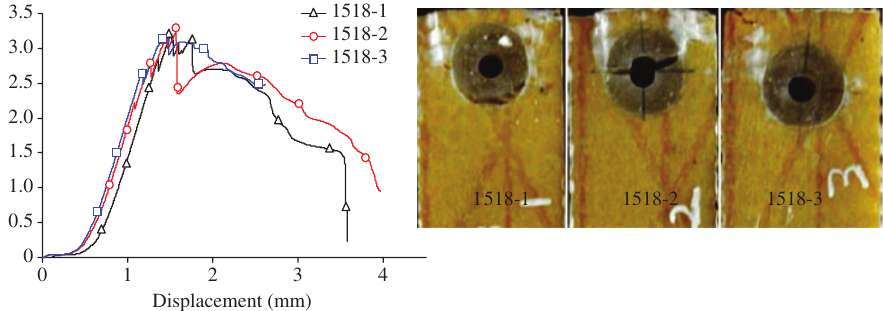
Figure 10 Load-displacement variations and images of the damaged samples for E = 15 mm and D = 18